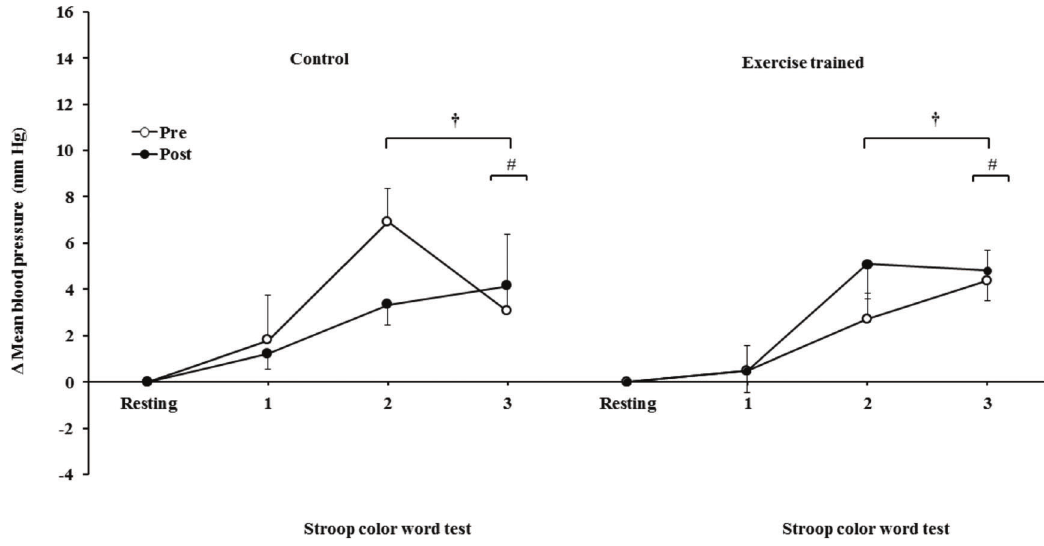
Figure 5D - Ankle mean arterial BP responses during the SCWT. w = versus rest, p o 0.05 (within group in pre and post intervention/ control); # = versus first min of the SCWT p o 0.05 (within group in pre and post intervention/control). Values are mean ± SD.BP = blood pressure; SCWT = Stroop Color Word